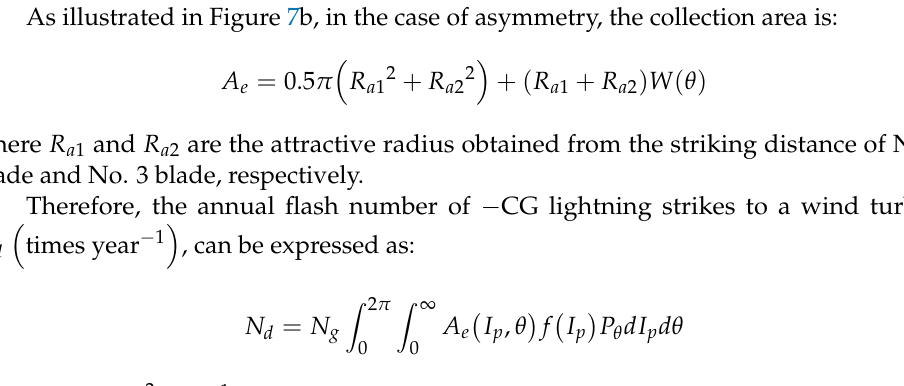
Figure 7. The lightning collection area of a wind turbine: ( a ) symmetrical state, ( b ) asymmetrical state.